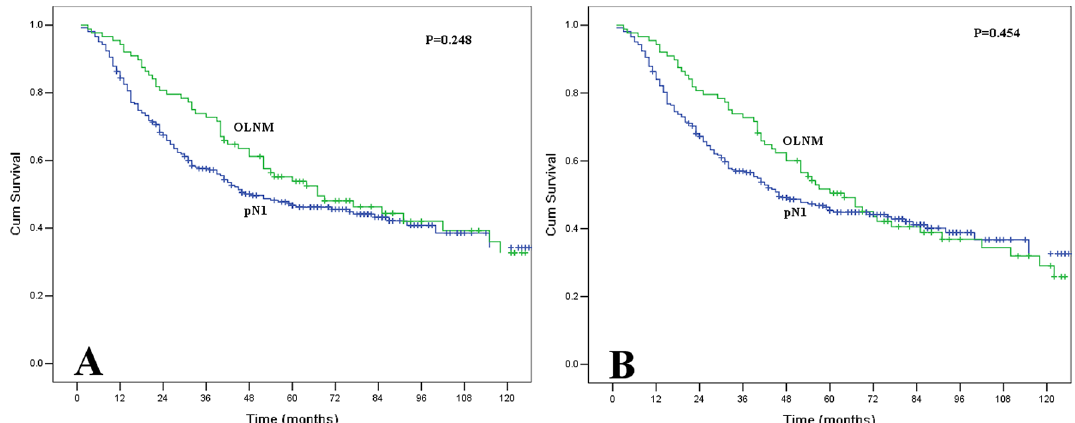
Figure 6. ( A ) Comparisons of overall survival between the patients with occult lymph node metastases and patients with pN1 by routine histopathological analysis. The differences in survival were not significant (P = 0.248). ( B ) Comparisons of disease-free survival between the patients with occult lymph node metastases and patients with pN1 by routine histopathological analysis. The differences in survival were not significant (P =